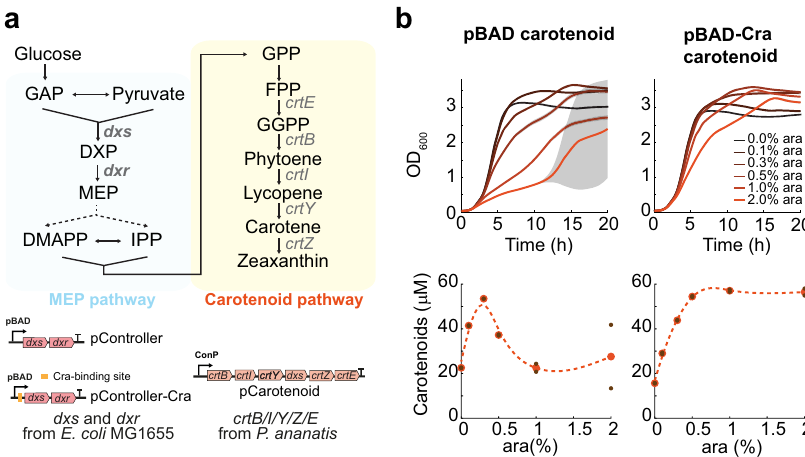
Fig. 6 A Cra-regulated pBAD promoter improves overproduction of carotenoids. a Metabolic map of the E. coli methylerythritol phosphate (MEP) pathway and the synthetic carotenoid pathway. Expression of the fi rst enzymes in the MEP pathway (1-deoxy- D -xylulose-5-phosphate synthase, Dxs; and 1- deoxy- D -xylulose 5-phosphate reductoisomerase, Dxr) was controlled with a pBAD promoter (plasmid pController) or with a pBAD-Cra promoter (plasmid pController-Cra). The carotenoid pathway consists of fi ve enzymes from P. ananatis : geranylgeranyl diphosphate synthase (CrtE), phytoene synthase (CrtB), phytoene dehydrogenase (CrtI), lycopene beta-cyclase (CrtY), and beta-carotene hydroxylase (CrtZ). These fi ve genes were expressed under the control of a native constitutive promoter from P. ananatis and one additional dxs gene from E. coli (plasmid pCarotenoid). b Plasmids pCarotenoid and pController were co-expressed in E. coli (pBAD carotenoid strain). Both strains were grown in a plate reader at different induction levels for Dxs and Dxr (0, 0.1, 0.3, 0.5, 1, and 2% ara). The total carotenoid content was measured after 24 h. Growth curves and dots show means of n = 2 cultures, and gray shaded areas show the difference between the two cultures. GAP glyceraldehyde-3-phosphate, DXP 1-deoxy- D -xylulose-5-phosphate, MEP 2-C-methyl- D - erythritol-4-phosphate, DMAPP dimethylallyl diphosphate, IPP isopentenyl diphosphate, GPP geranyl diphosphate, FPP farnesyl diphosphate, GGPP geranylgeranyl diphosphate. Source data are provided in the Source Data fi